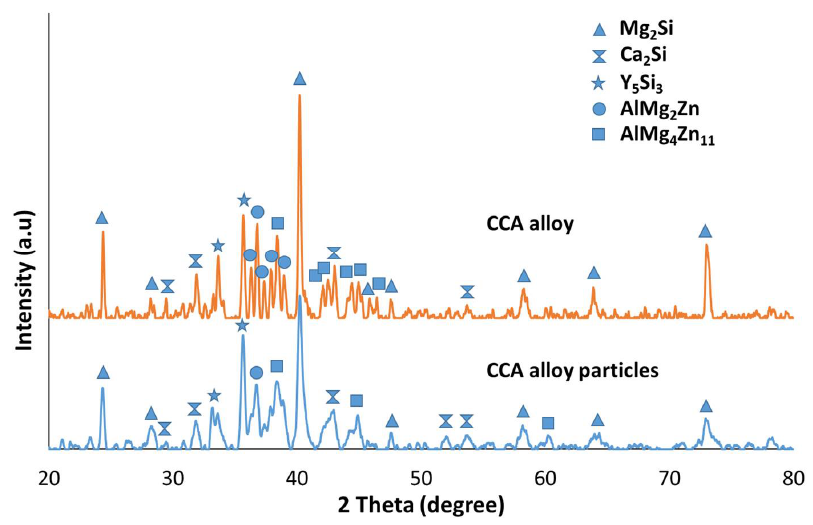
Figure 2. X-ray diffraction (XRD) pattern of the cast CCA alloy and ball-milled CCA alloy particles.